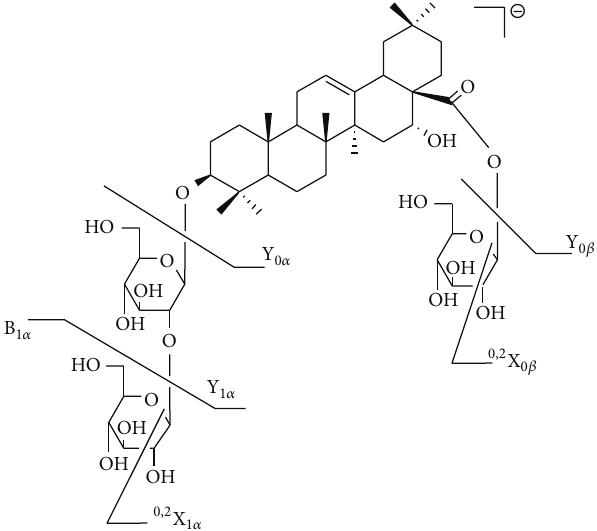
Figure 4: The fragmentation nomenclature of compound 10